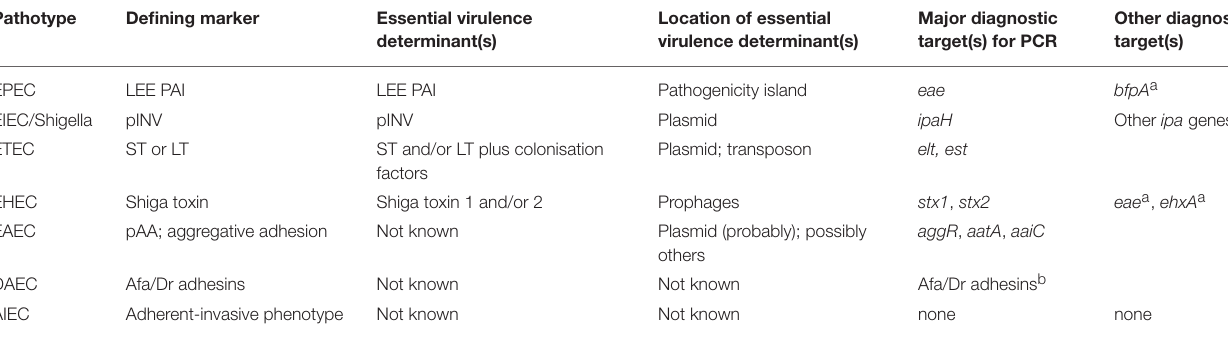
TABLE 1 | Virulence-associated markers of diarrheagenic E. coli from humans.